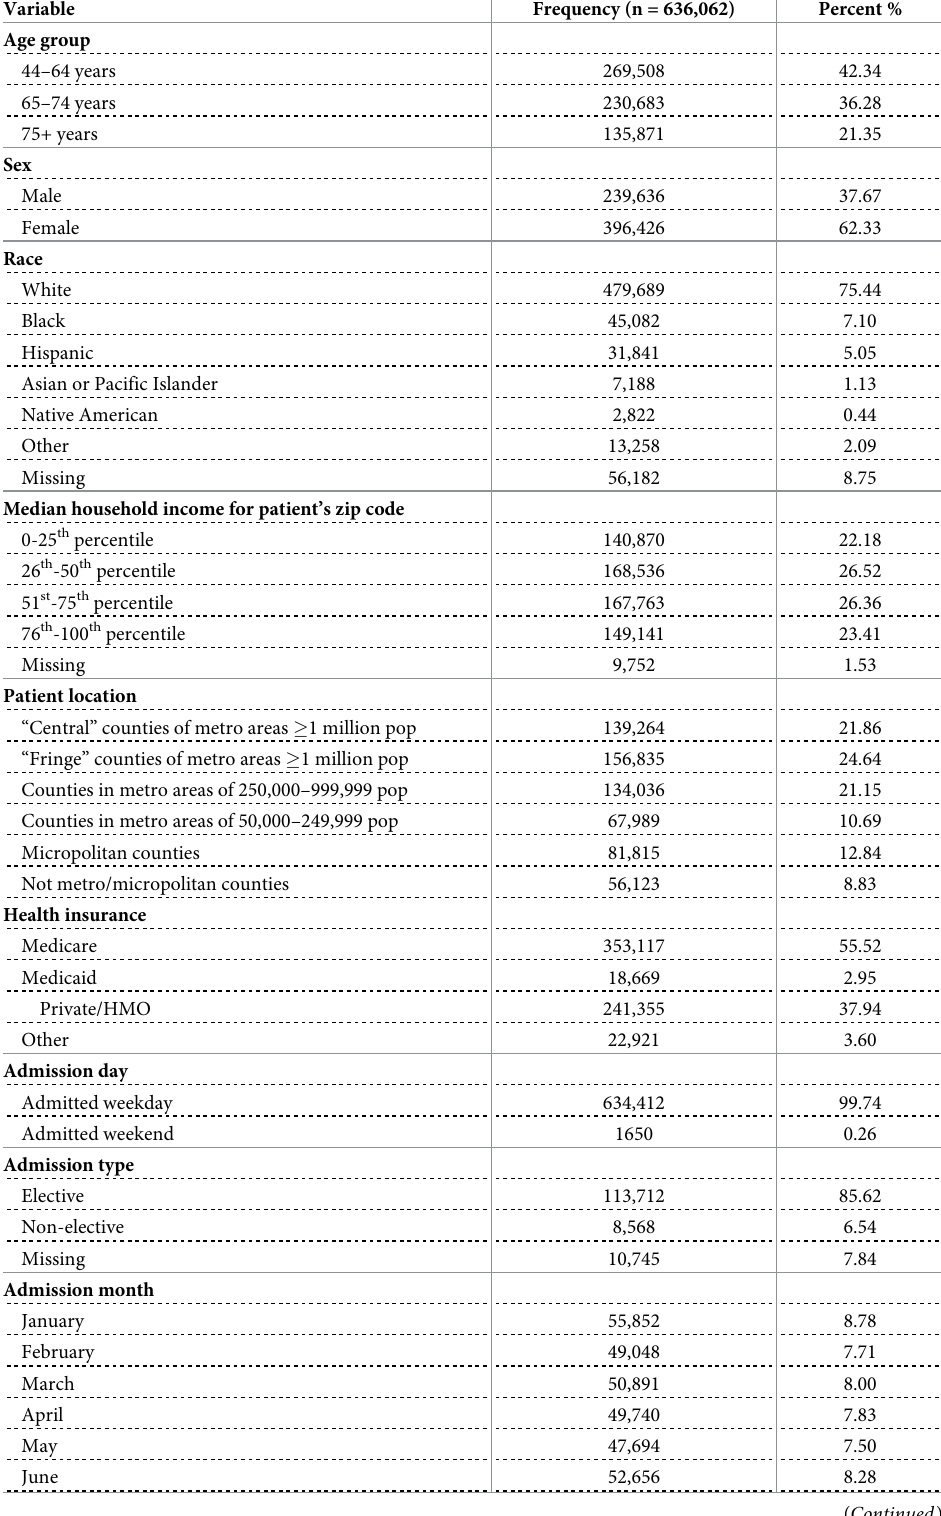
Table 1. Characteristics of patients with total knee arthroplasty discharges in 2010–2014 NIS